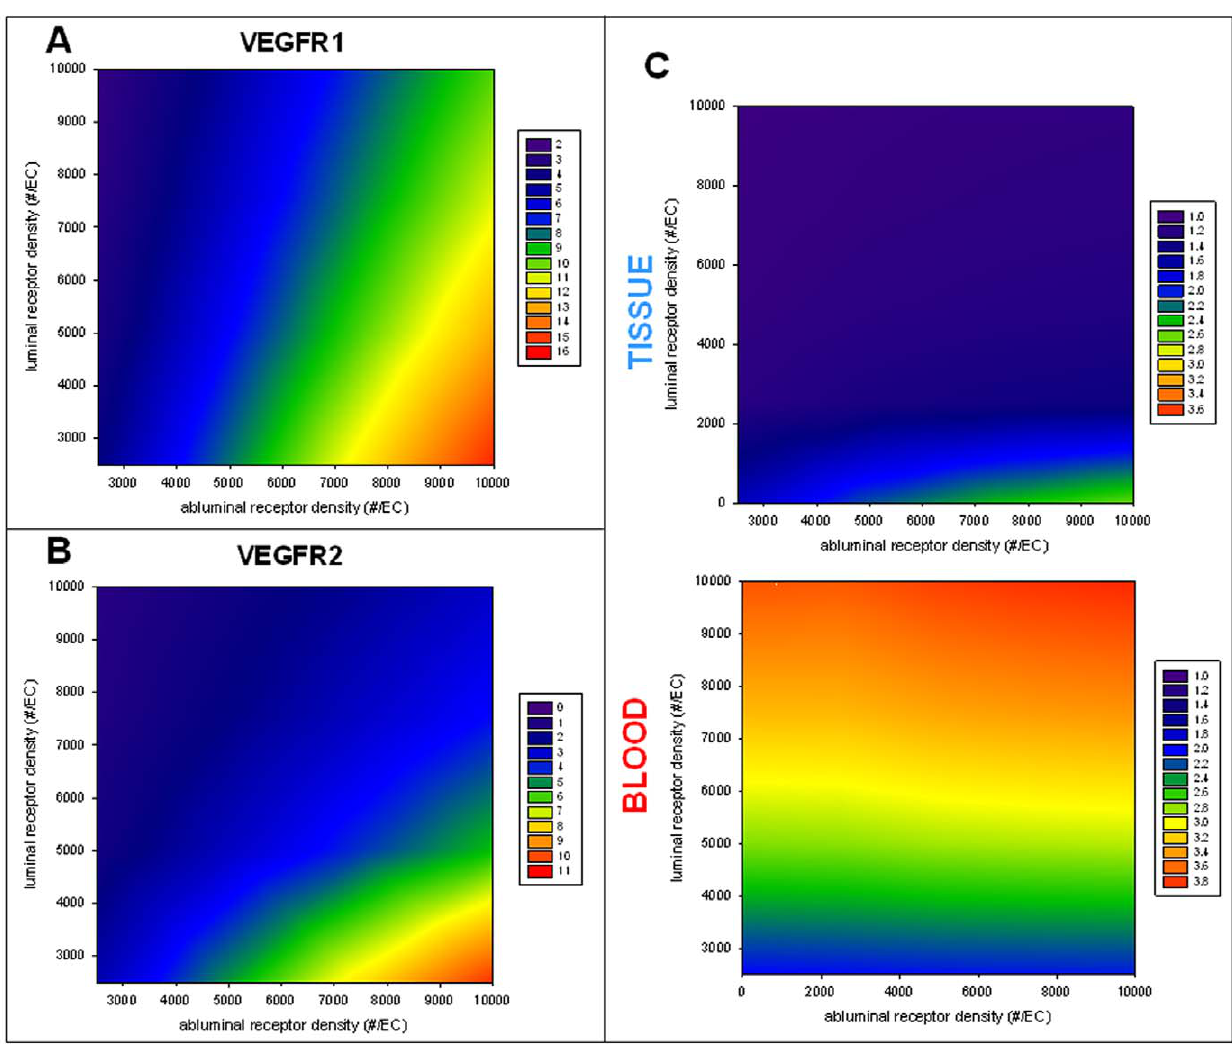
Figure 9. VEGF signaling. A. Ratio [VEGF bound to abluminal VEGFR1]/[VEGF bound to luminal VEGFR1]. B. Ratio [VEGF bound to abluminal VEGFR2]/[VEGF bound to luminal VEGFR2]. C. Ratio [VEGF bound to VEGFR2]/[VEGF bound to VEGFR1]. Top row: tissue; bottom row: